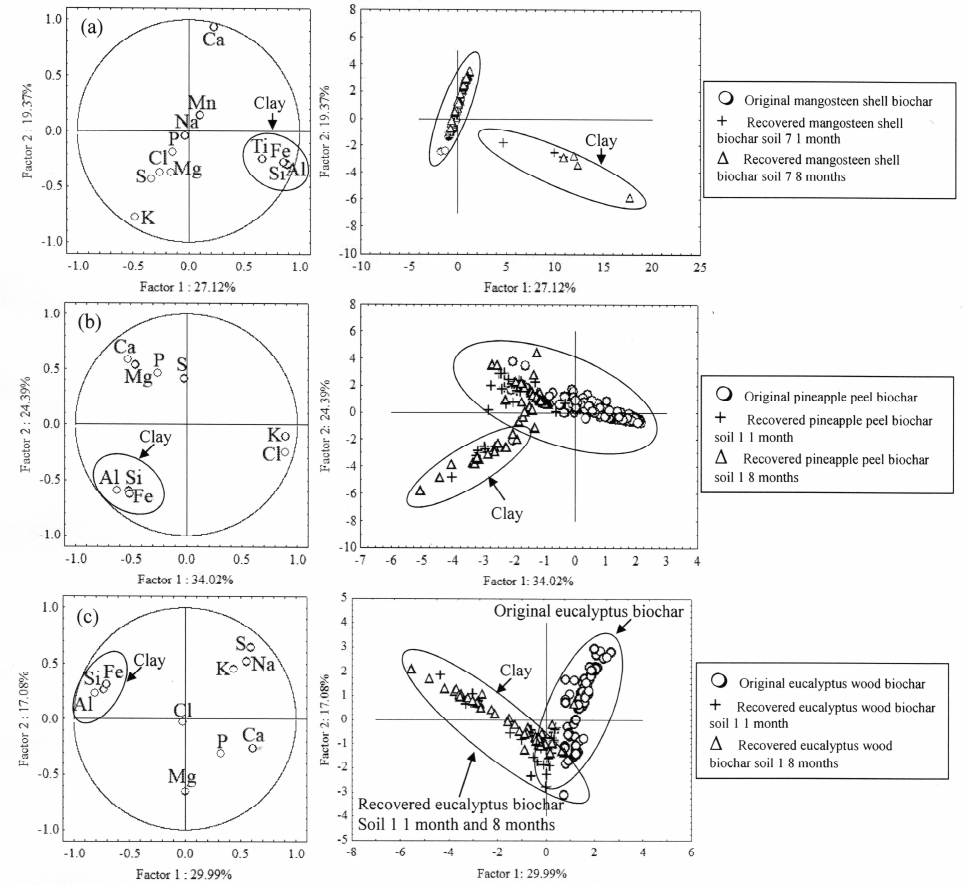
Figure 8. Factor plots for SEM-EDS chemical analyses of individual mineral particles in mangosteen ( a ), pineapple peel ( b ), and eucalyptus wood ( c ) biochars. The biochars had been incubated in soils for zero, one, and eight months.